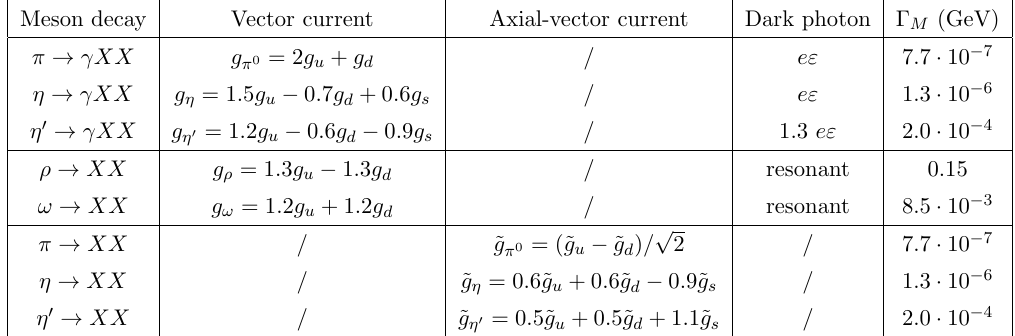
Table 2 . Approximate scaling of the e(cid:11)ective couplings for the various meson decays through vector and axial-vector currents, presented in section 2. The dark photon case is also listed for comparison. We refer the reader to appendix A for details. The last column lists the Standard Model width of the meson, (cid:0) M